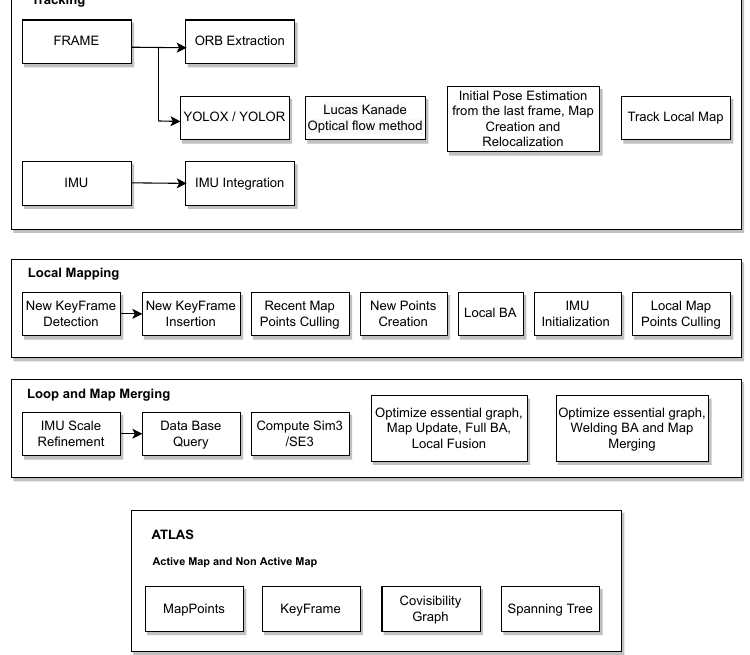
Figure 2. ORB-SLAM3 with YOLO system